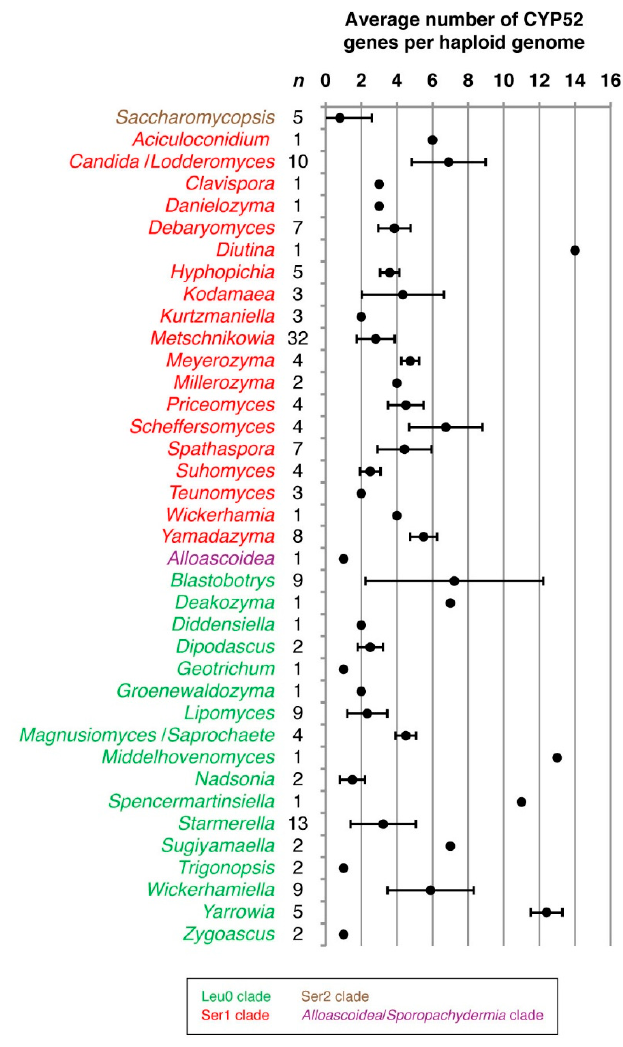
Figure 3. Average gene copy number of CYP52 family genes per haploid genome among budding yeasts. Genus names are color-coded with respect to clade [24]. The number of species surveyed within each genus ( n ) is indicated. Error bars indicate one standard deviation.